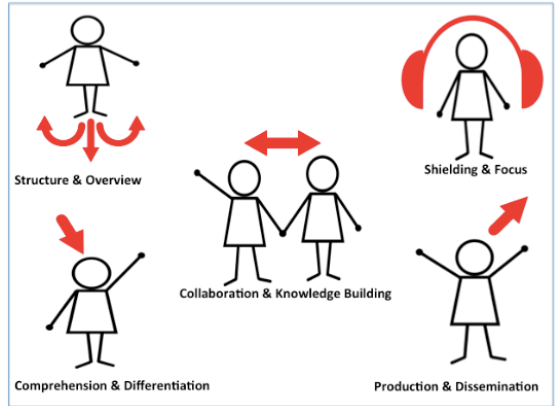
Figure 1. Five-type-model of including, ICT based